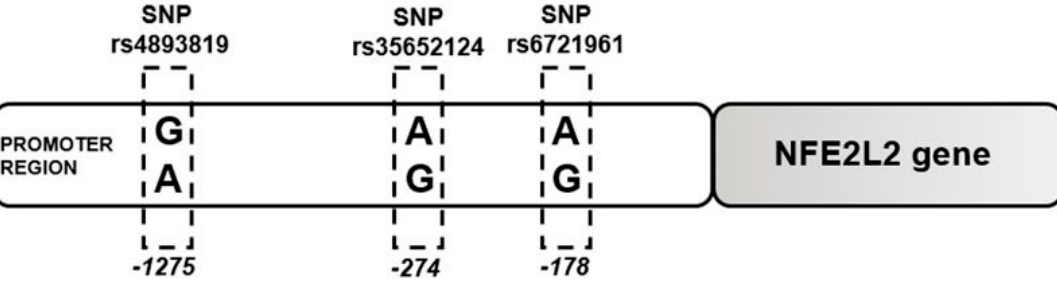
Figure 1. Schematic position of the selected polymorphisms in nuclear factor erythroid 2-related factor 2 gene (NFE2L2). The three polymorphisms studied in this work are localized in promoter region of NFE2L2 gene. Single Nucleotide Polymorphism (SNP) rs6721961 is located at position -178, where can be present an adenine (A) or guanine (G). SNP rs35652124 is in position -274 in the promoter region, and the variation is the same of the first. Lastly, SNP rs4893819 is localized in position -1275 in the promoter region of NFE2L2 gene. In this position, the variation occurs between G and A. All these positions are considering the position in relation 3’ → 5’.